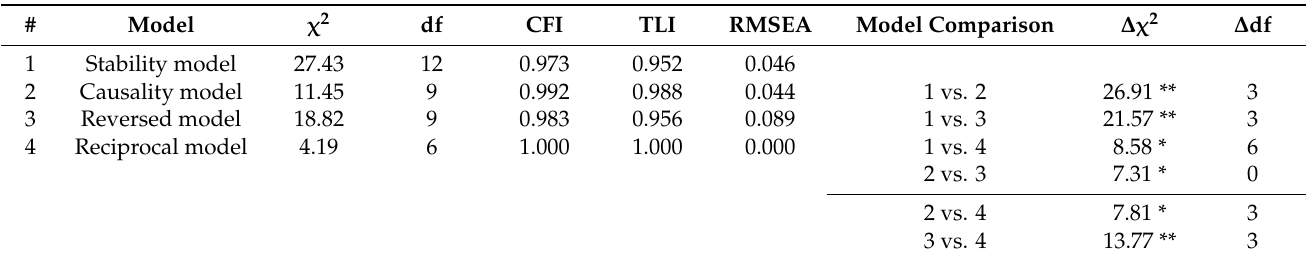
Table 5. Model comparison.